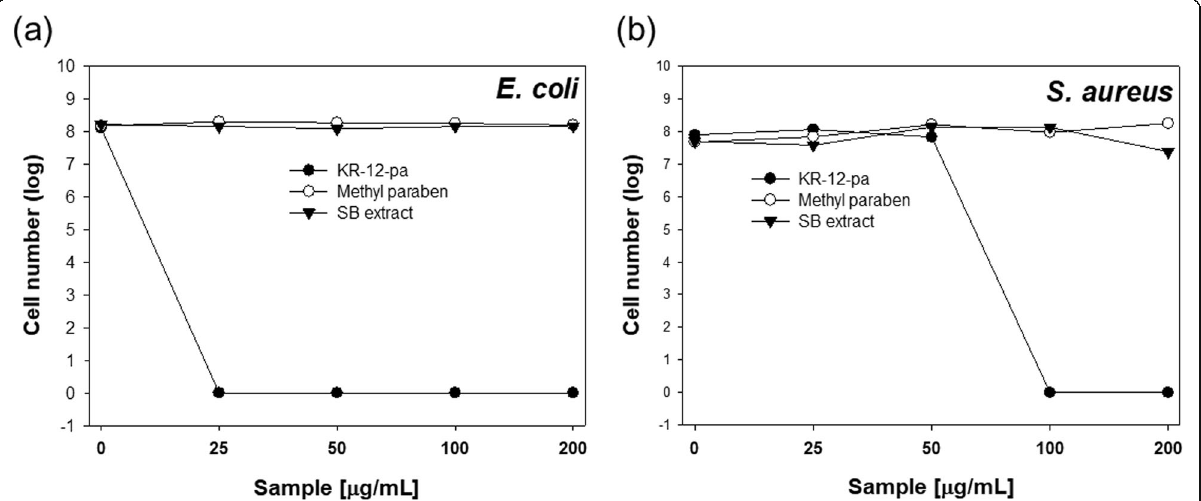
Fig. 5 Bactericidal activity of KR-12-pa, methylparaben, and Scutellaria baicalensis (SB) against gram-negative E. coli ( a ) and gram-positive S. aureus ( b )